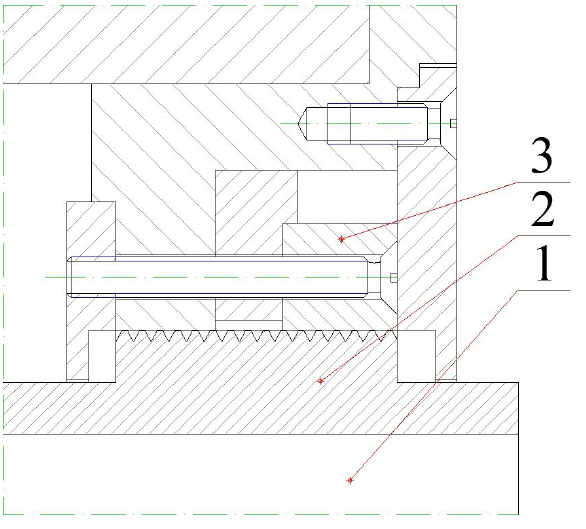
Figure 5: The drawing of the MFSC gas-blower.